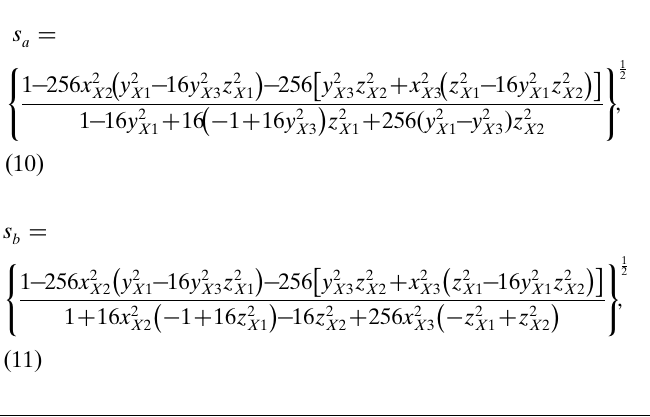
p p ffiffiffi ffiffiffi (cid:4) (cid:4) 2 supercell of the cubic aristotype, 2 2